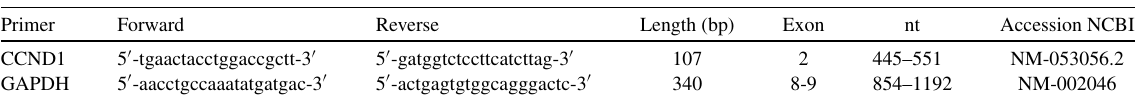
Oligonucleotide primer sequences used for